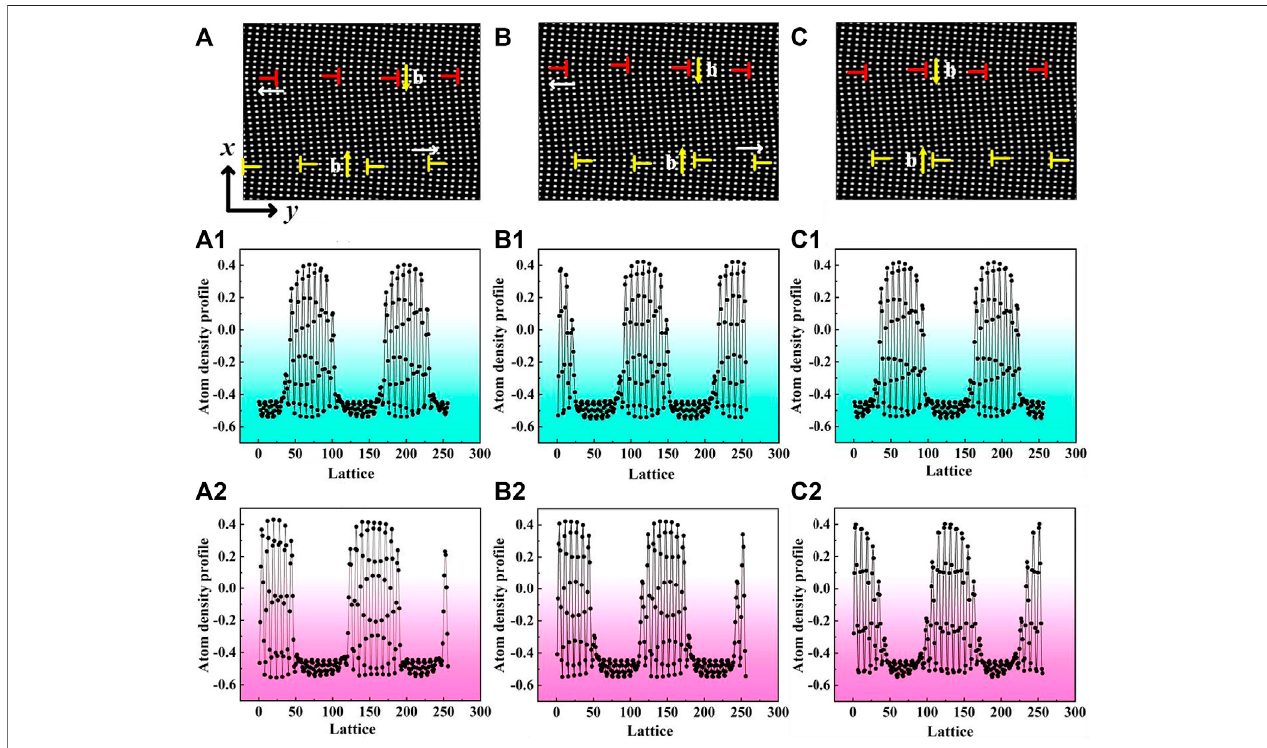
FIGURE 2 | (A) , (B) Bi-crystal structure with grain boundary misorientation angles of 6 ° and 7 ° under x -direction tensile strain, and the time steps is 5,000. (C) The bi-crystal structure withgrainboundary misorientationangles of7 ° under y -direction tensile strain, and the time steps is5,000. (A1 – C1) The atomic density pro fi le ofthe upper grain boundary corresponding to the misorientation angle, respectively. (A2 – C2) The atomic density pro fi le of the down grain boundary corresponding to the misorientationangle.Thewhitearrowindicatestheclimbingdirectionoftheedgedislocation. TheyellowarrowindicatesthedirectionofBurgersvectoroftheedge